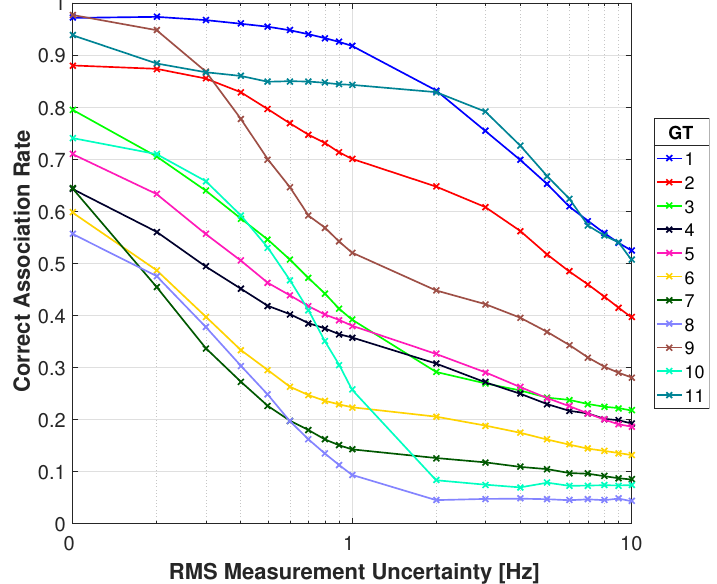
Figure 15. Correct association rate for matching specific cellular emanation measured by the constellation of RF receivers with the corresponding target from the multi-spectral video tracker using the absolute DD.